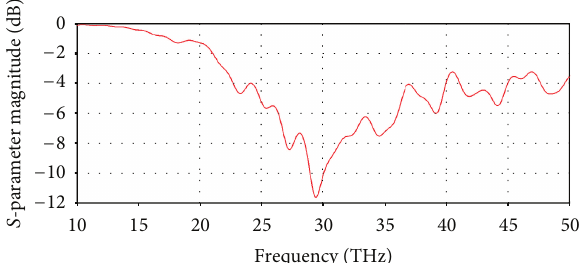
Figure 3: Magnitude of input reflection coefficient (in dB).